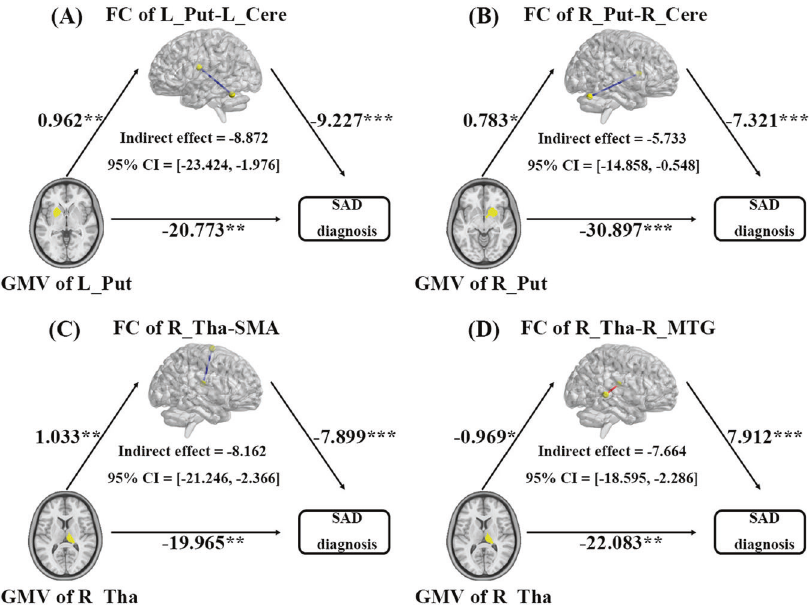
Fig. 3 Mediating role of rs-FC de fi cits on the effects of GMV abnormalities on SAD diagnosis. Unstandardized regression coef fi cients are displayed (* P < 0.05, ** P < 0.01, *** P < 0.001). Age, sex, total intracranial volume, and mean framewise displacement were controlled for in the model. Abbreviations: CI, con fi dence interval; GMV, gray matter volume; HCs, healthy controls; L_Cere, left cerebellum; L_Put, left putamen; R_Cere, right cerebellum; R_MTG, right middle temporal gyrus; R_Put, right putamen; rs-FC, resting-state functional connectivity; R-Tha, right thalamus; SAD, social anxiety disorder; SMA, supplementary motor